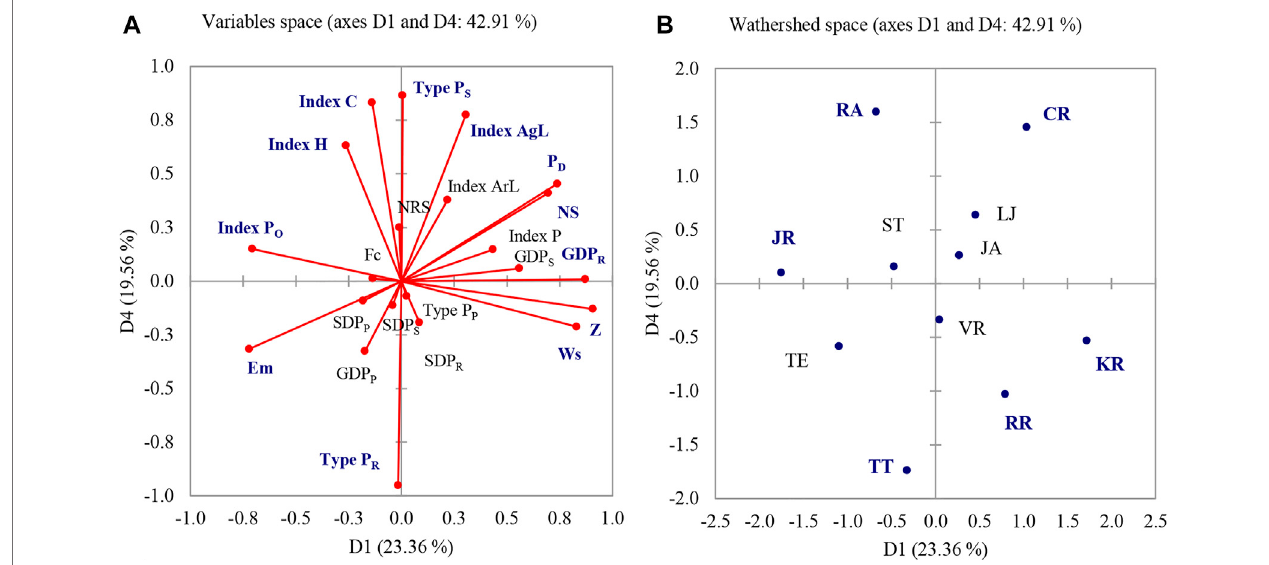
FIGURE 7 | Weight plot of the D1 and D4 components (A) and watersheds space (B) (Weight plot of the predictors with the highest weights on the individual variables are highlighted with bold).